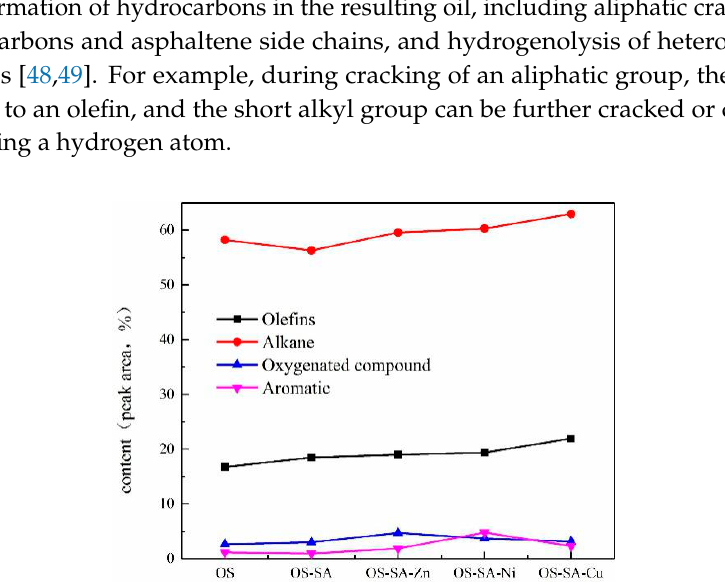
Figure 8. Relative content of main components in shale oil.